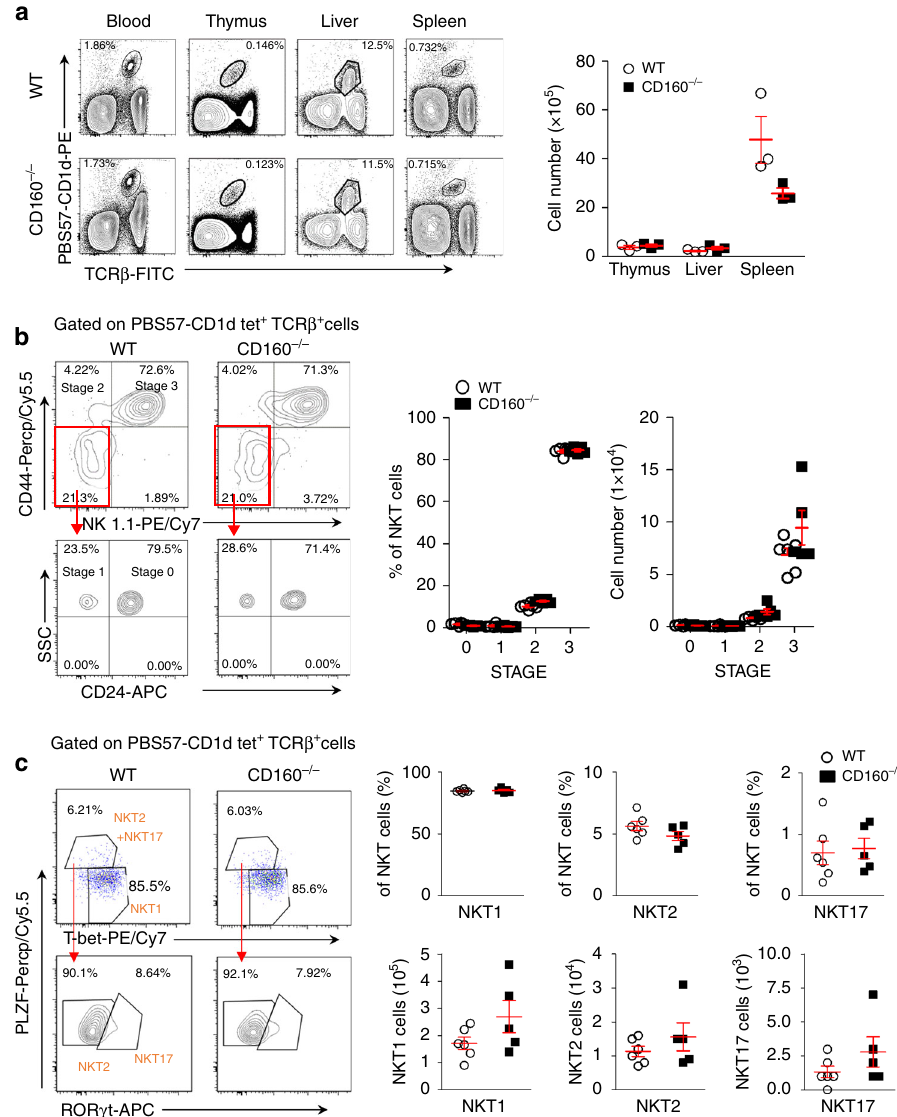
Fig. 2 Absence of CD160 does not affect the development of NKT cells. a Lymphocytes from blood, thymus, liver, and spleen in WT and CD160 − / − mice were stained with anti-TCR β FITC and PBS57-CD1d tetramer PE and analyzed by fl ow cytometry. Results are representative of three independent experiments. The absolute number of TCR β + PBS57-CD1d Tetramer + NKT cells in the thymus, liver, and spleen was calculated based on the percentage of each population shown in ( n = 3 per group). b Flow cytometry analysis of CD44 and NK1.1 expression among total NKT cells from the thymus of WT and CD160 − / − mice. Results are representative of three independent experiments. The percentages and numbers of thymic NKT cells at stage 0 (NK1.1 − , CD44 − , CD24 + ), stage 1 (NK1.1 − , CD44 − , CD24 − ), stage 2 (NK1.1 − , CD44 + ), and stage 3 (NK1.1 + , CD44 + ), based on fl ow cytometry analysis. Results are representative of three independent experiments. ( n = 5 – 6 per group). c Thymic NKT cells were gated on PLZF, T-bet and ROR γ t and the percentage and absolute numbers of NKT1, NKT2, and NKT17 were calculated ( n = 5 – 6 per group). All data are presented as mean ± S.E.M. * P < 0.05, ** P < 0.01, *** P < 0.001 with an unpaired two-tailed T